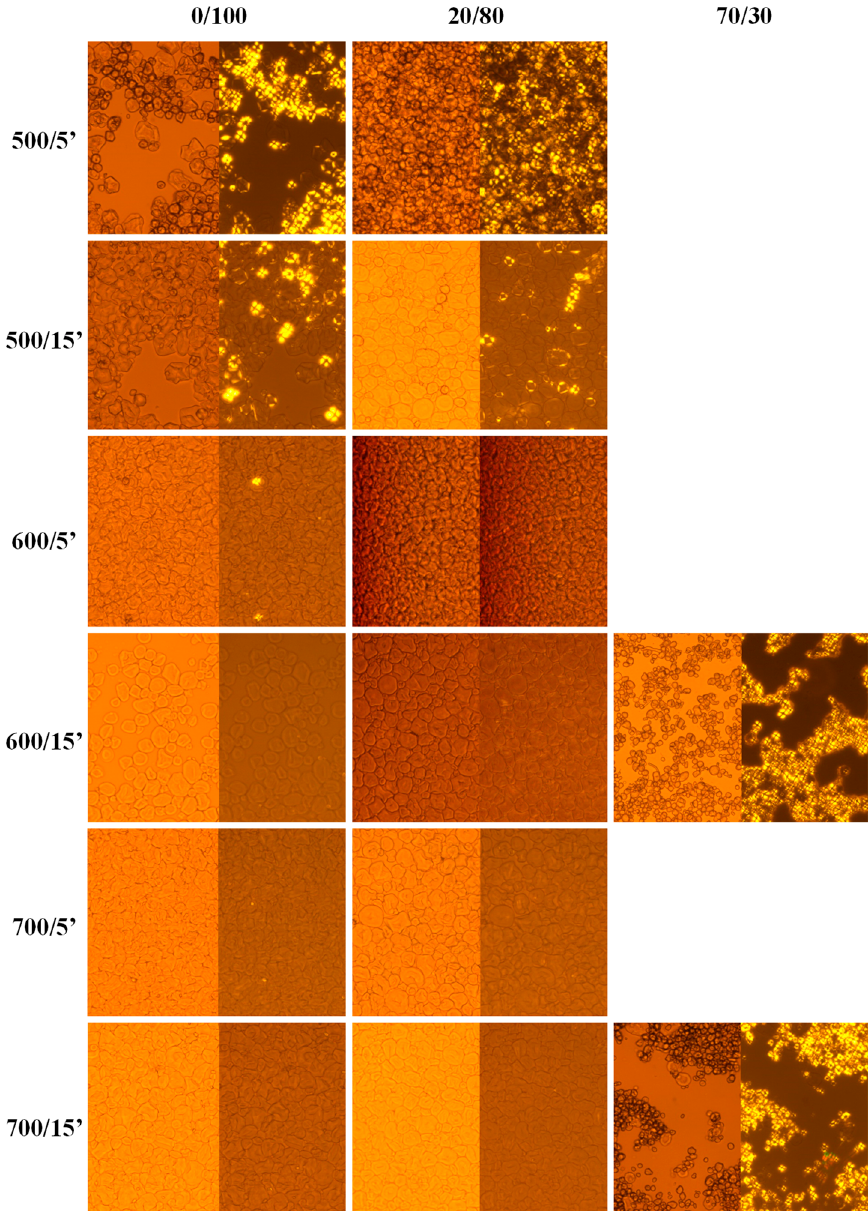
Figure 1. Micrographs taken under normal light (left hand side) and polarized light (right hand side, respectively) of waxy (0% amylose/100% amylopectin), normal (20% amylose/80% amylopectin), and high-amylose (70% amylose/30% amylopectin) corn starch suspensions HPP-treated at 500, 600, and 700 MPa for 5 and 15 min.